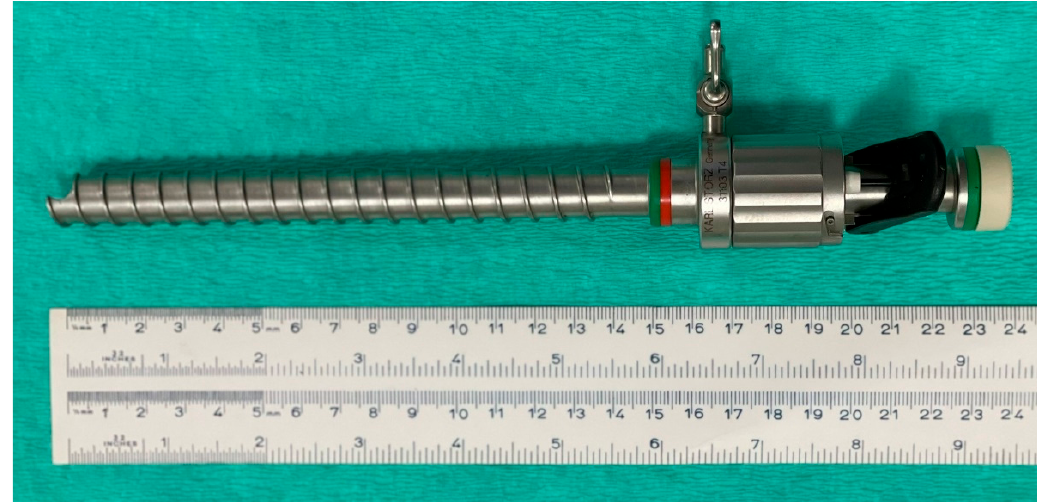
Figure 5. Device used in Group H. Optical helical cannula (12 mm, 15 cm length).